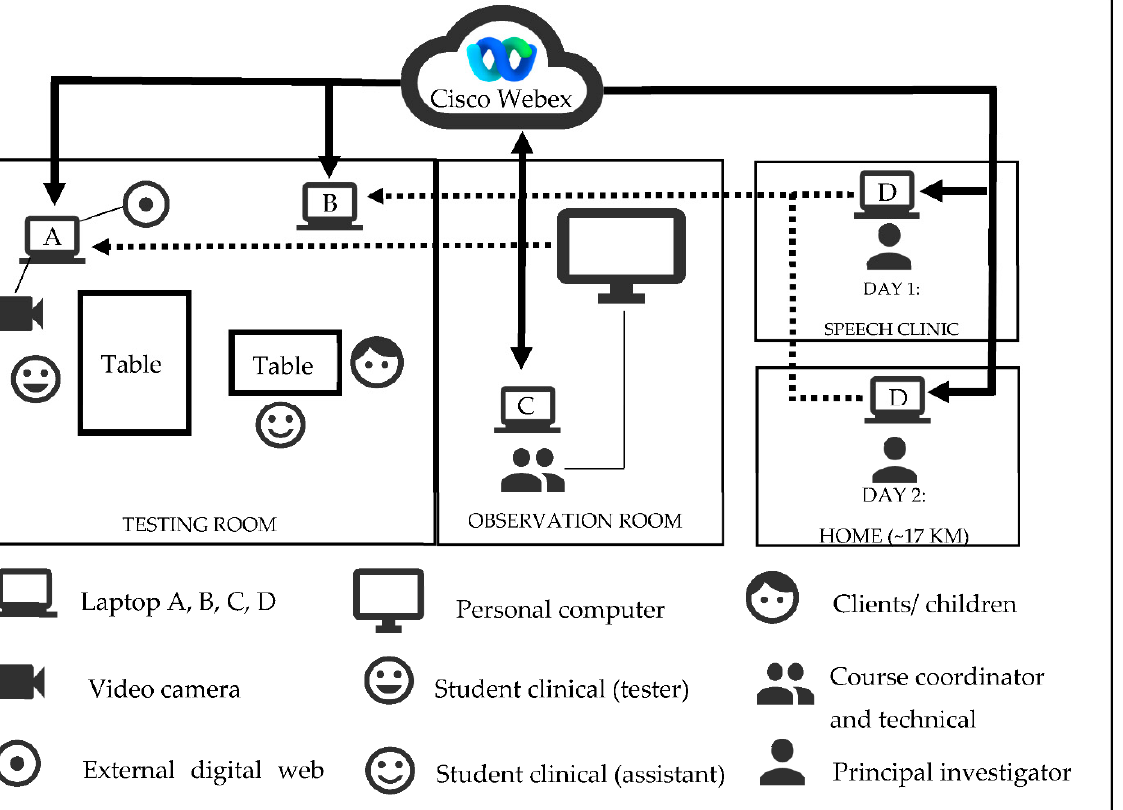
Figure A2. Mean values for Internet speed measurements using three different laptops. 16.75